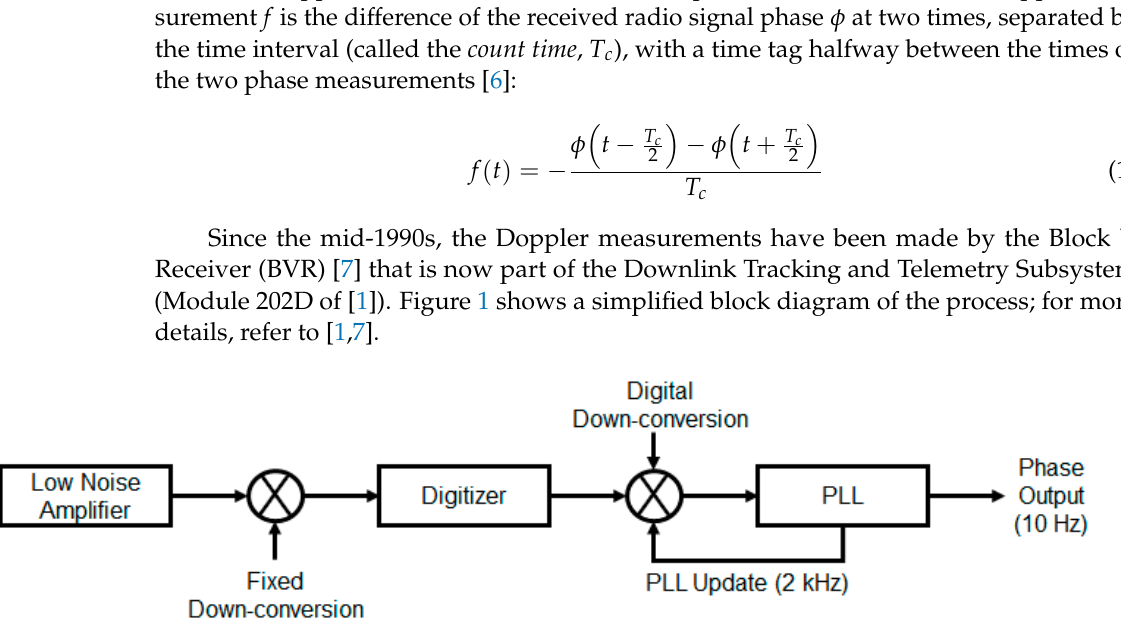
mediate frequency (IF) of about 200 MHz using a fixed frequency downconverter. The IF signal is undersampled at 160 Msamples/sec to provide a band from 0 to 80 MHz. The